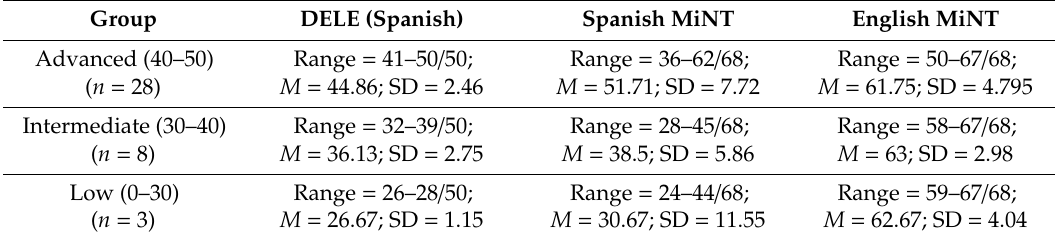
Table 3. Participants’ Multilingual Naming Test (MiNT) scores in Spanish and English in comparison with their DELE ( Diploma de Español como Lengua Extranjera ) scores. DELE